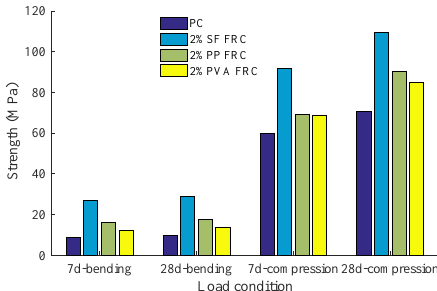
Figure 2. Fiber reinforcement effect on compressive and flexure